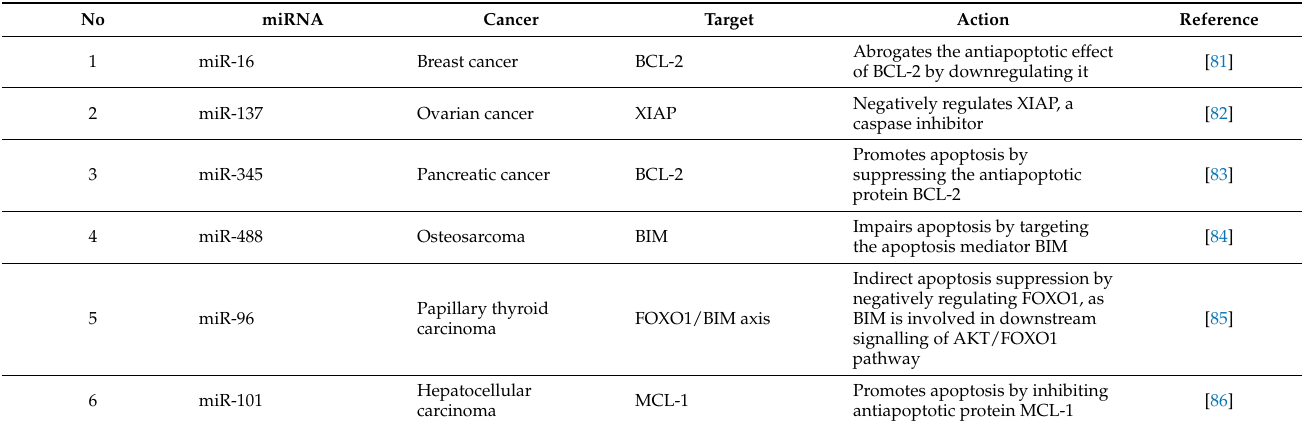
Table 4. The miRNAs implicated in